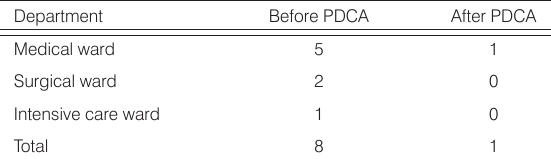
Table 3. The events related to drugs before and after the PDCA cycle